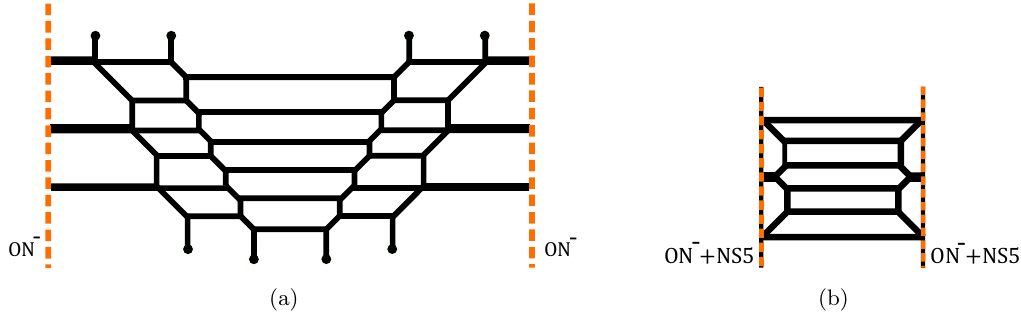
Figure 10 . (a) A 5-brane diagram for the SU(6) 0 (cid:0) [SU(3) 0 ] 4 a(cid:14)ne D 4 quiver theory. (b) A 5-brane web for the SU(6) 0 gauge theory with N TAS = 2 which is obtained from a Higgsing from the diagram in (cid:12)gure 10(a).